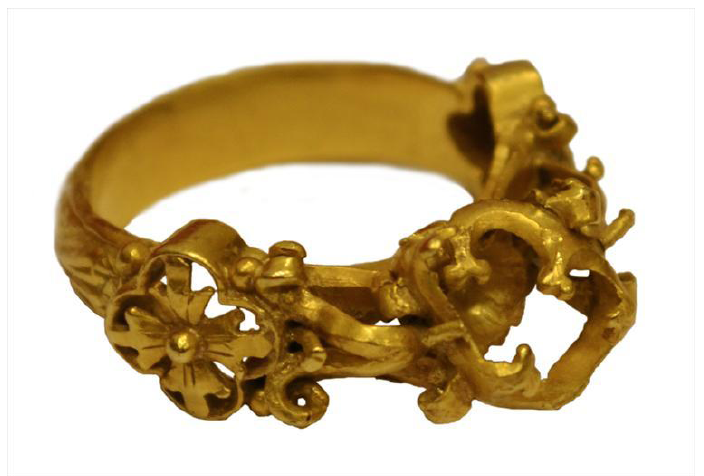
Fig. 4. The medieval gold ring from Espoo, Finland. Photograph by Laura Kannasmaa, Espoo City Museum. While it has been reported in the media that the Collections Unit at the NBA are ‘drowning’ in detectorist finds (YLE 2014b; Lehtinen 2014) it is also important to note that not all finds with an age exceeding 100 years are reported or even taken into museum collections. These finds are mostly refuse, such as melted pieces of bronze and lead, which are often left unidentified. However there are also coins and fragments of finds that derive from post-medieval and early modern periods, which finders perhaps do not perceive as being’ interesting enough’ to report because they are so common. It has been estimated that only 10% of coins deriving from AD 1523 onwards are reported onwards to the authorities (Kankaanpää 2016, 26). While some of the finds are not recognized due to lack of specialist expertise on these periods among NBA and museum staff, the majority of finds are excluded from the collections because they are considered either too young or as mass finds or bulk, which are often found in the topsoil of fields. Fortunately also these finds are now being documented by the NBA even if ultimately not accessioned into the collections. For example the Numismatic department at the National Museum has started to do so with coins since 2013 (Ehrnsten 2015,